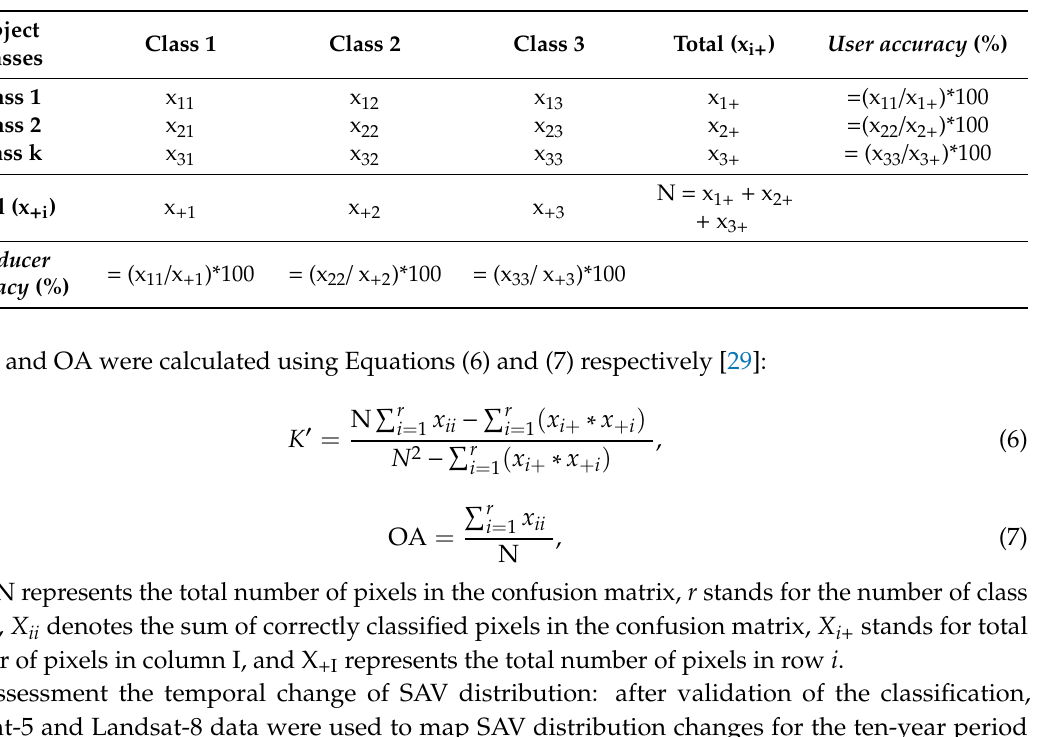
Table 6. Confusion matrix table for calculating Overall, User, and Producer accuracies.